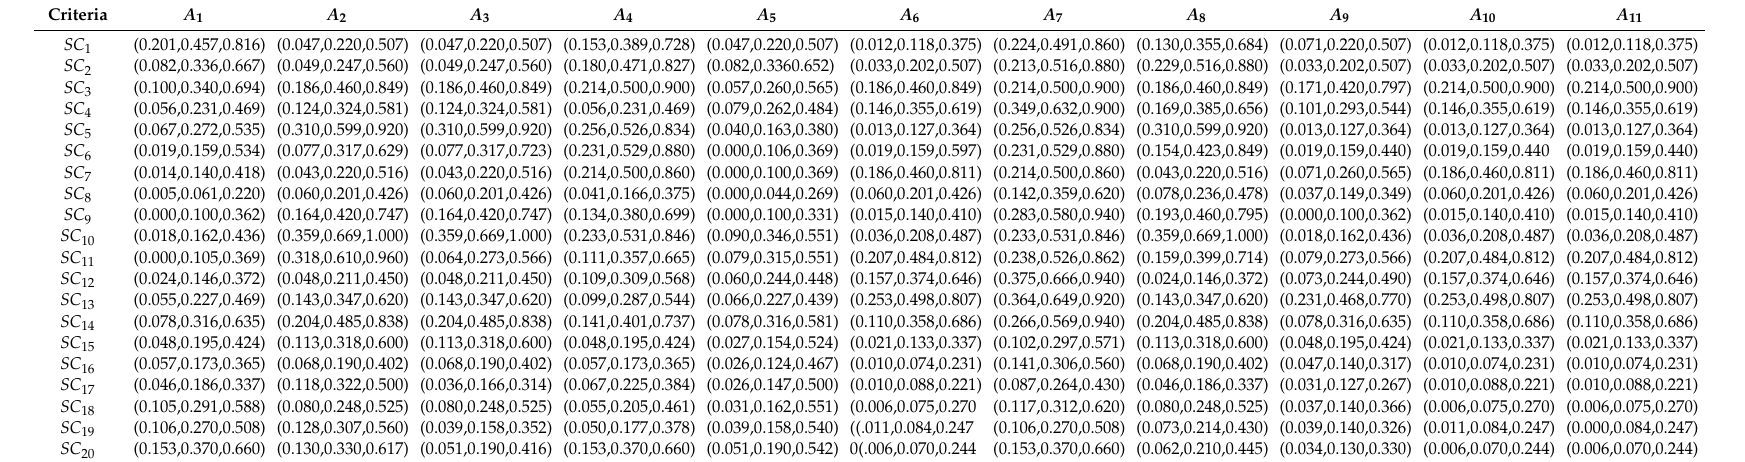
Table 5. The fuzzy weighted normalized decision matrix of Sustainable Siliceous materials